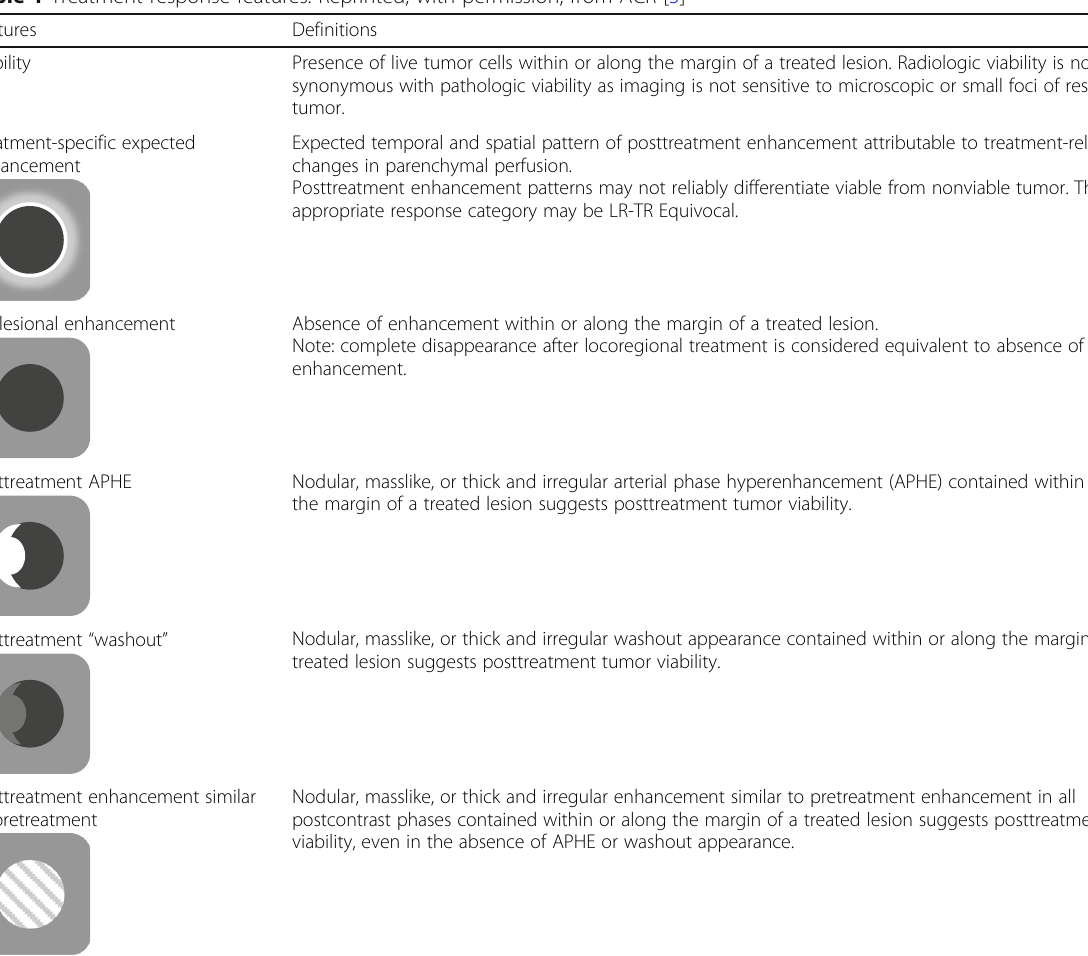
Table 1 Treatment response features. Reprinted, with permission, from ACR